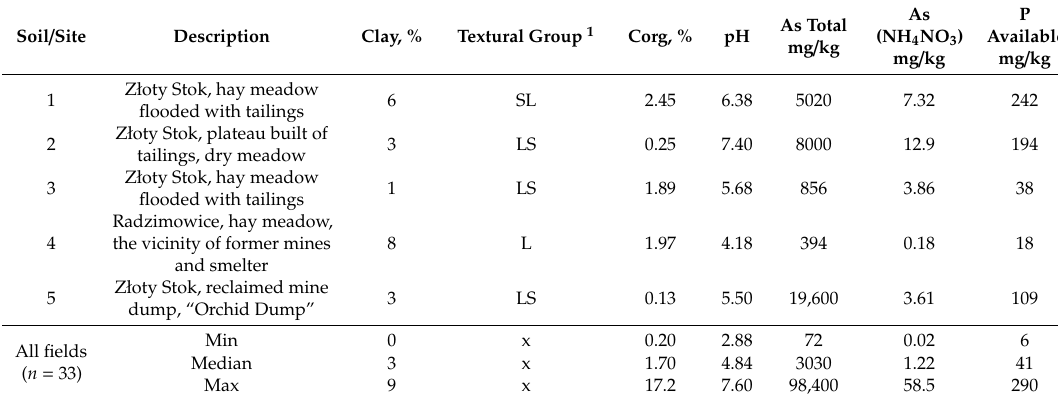
Table 2. Properties of soils used in the greenhouse experiment (mean values of five replicates) and examined in the field